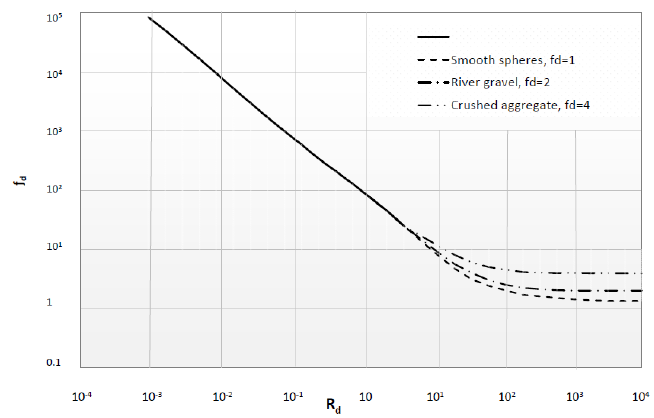
Figure 3. Schematic diagram [ R d , f d ] proposed by Stephenson (1979) [17]. For laminar flow, considering the analogy with the flow in pipes and based on data from Dudgeon (1966) [10]and Cedergren (1977) [41], he proposed the relationship: where 𝐾 𝑙 is the linear dimensionless coefficient from Stephenson (1979) [17]. The value of 𝐾 𝑙 obtained from the experimental data was 800. The limit of the Reynolds number 𝑅 𝑑 for the laminar regime proposed by Stephenson was 𝑅 𝑑 = 10 −4 . In the transition zone, he proposed Equation (31) of the type given by Equation (10): 𝑓 𝑑 = 𝐾 𝑙 𝑅 𝑑 + 𝐾 𝑡 (31) where 𝐾 𝑡 is the quadratic dimensionless coefficient from Stephenson (1979) [17]. According to the author, Reynolds numbers of 𝑅 𝑑 > 10,000 produce the fully developed turbulent flow regime and, in this case, the author indicated that it was only a function of the shape and angularity of the particles. Ultimately, Equation (31) (similar to the generalised equation Equation (10)), the Ergun equation, i.e., Equation (21), and by implication Equation (25) by Frank Engelund, represent continuous curves for each porous medium in a generalised diagram [R e , 𝑓 ]